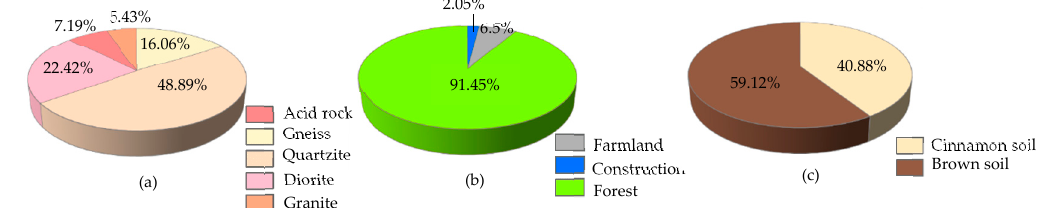
Figure 6. Subclass ratios of three influence factors: ( a ) lithology; ( b ) land use; ( c ) soil type.